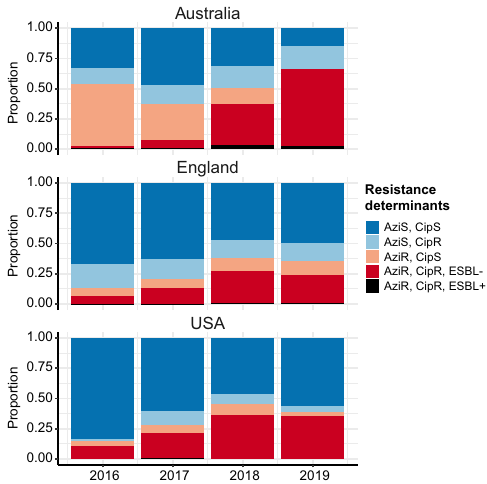
Fig. 5 Prevalence of combined resistance to cipro fl oxacin and azithromycin amongst genomes from each surveillance region. Stacked bar colours indicate the relative abundance of different combinations of resistances, predicted from genomes: CipR, cipro fl oxacin resistant (de fi ned as presence of ≥ 3 QRDR mutations); AziR, azithromycin resistant (de fi ned as carrying mph(A) ); ESBL + , presence of extended-spectrum beta-lactamase (ESBL) gene associated with resistance to third generation